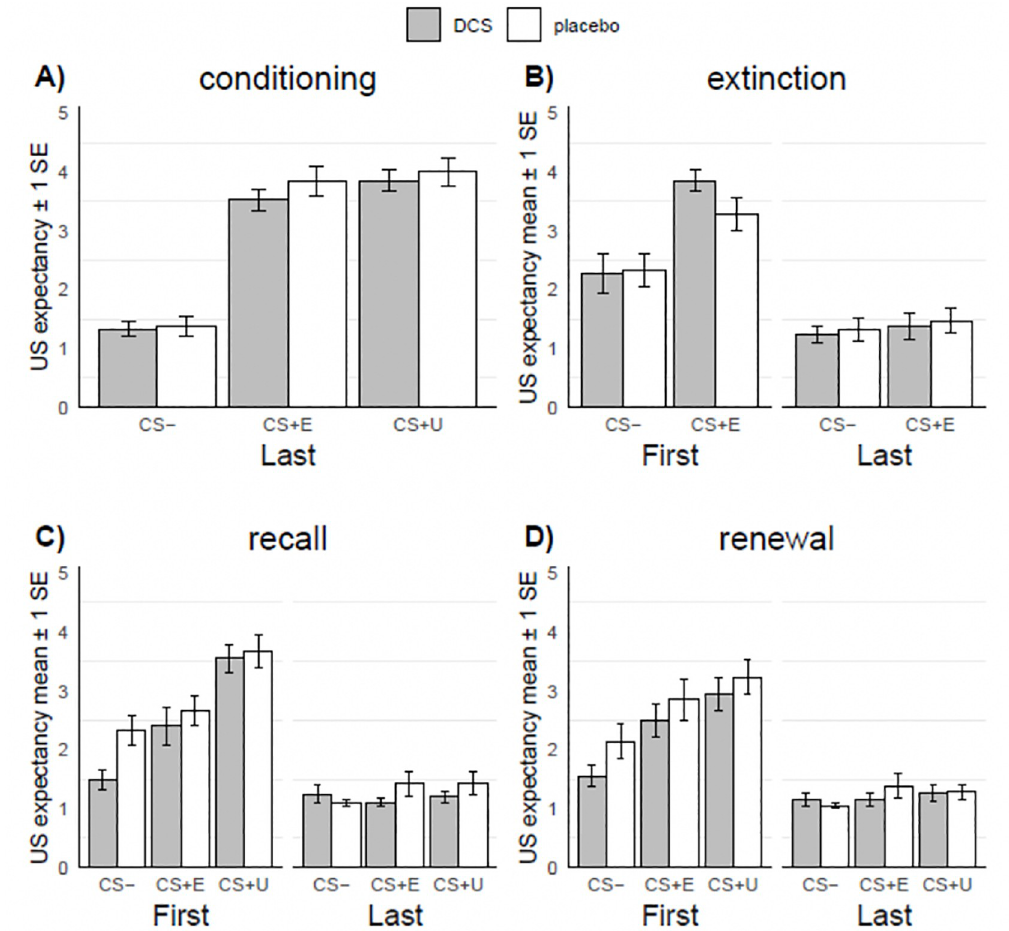
Fig 3. Expectancy of shock (US expectancy) following first and last presentation of different conditioned stimuli, across experimental phases. Note. Ratings were made retrospectively (i.e. after phase concluded). PBO = placebo group, DCS = d- cycloserine, SCR = skin conductance response, SE = 1 standard error, CS- = stimulus that was not paired with shock, CS +E = stimulus that was paired with shock during conditioning and presented in the extinction phase, CS+U = stimulus that was paired with shock during conditioning but not presented in the extinction